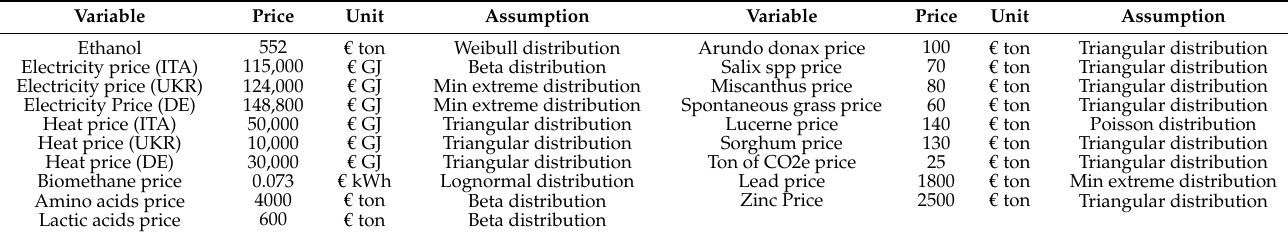
Table A4. Market prices and assumptions considered by the